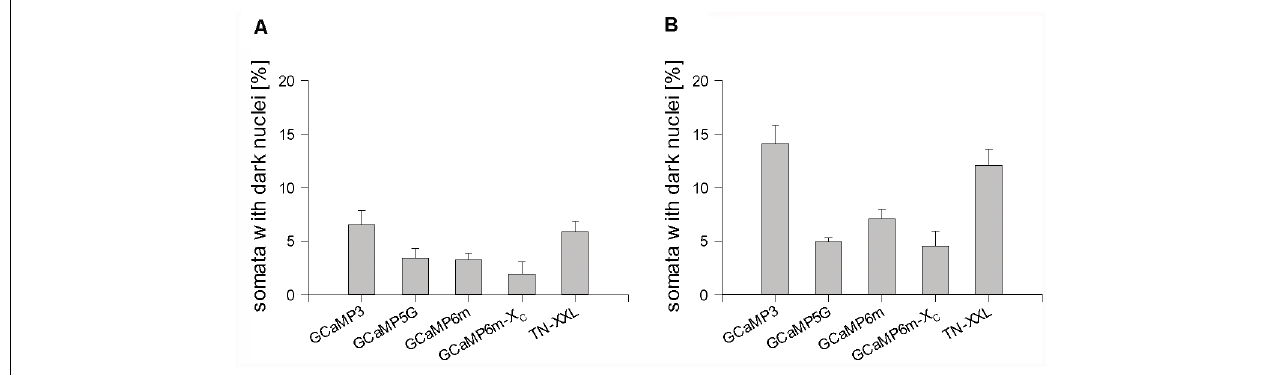
FIGURE 4 | Percentage of GECI expressing neuronal somata with the dark, occluded nucleus. (A) DIV 14. (B) DIV 22–25. The average per OTC was plotted as mean ± SEM. The total number of assessed somata, OTC, and independent preparations are reported in Supplementary Table S1 .